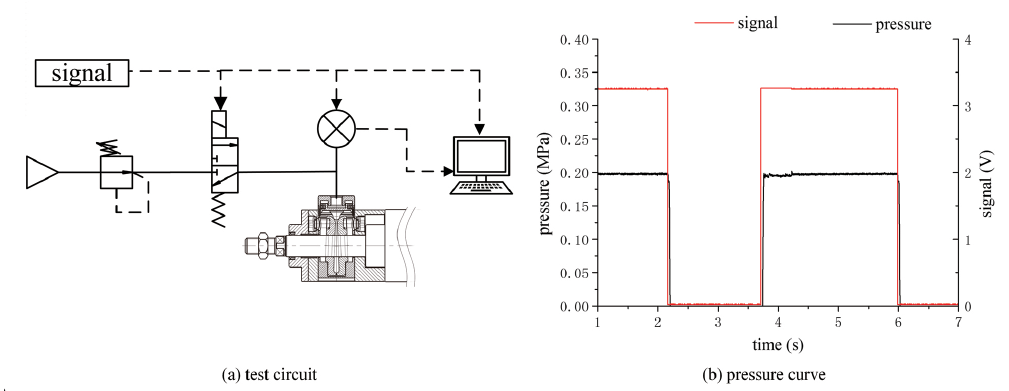
Figure 6. Test of the locking reaction delay.